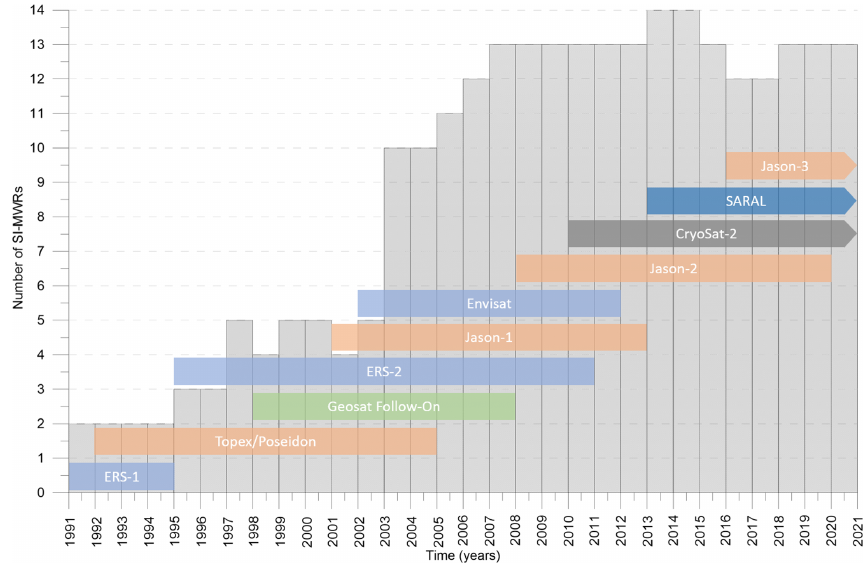
Figure 3. Number of SI-MWRs used in GPD + over time and period covered by each RA mission. SARAL, CryoSat-2 and Jason-3 missions are currently operational RA